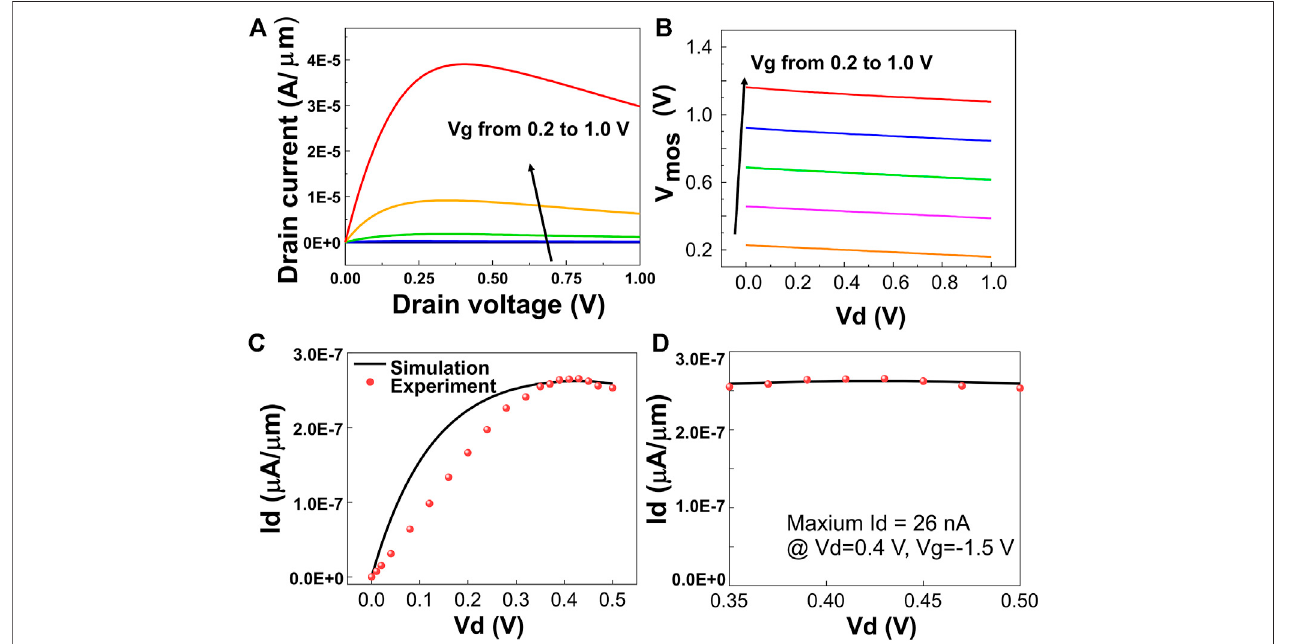
FIGURE 4 | NDR effect in device modeling. (A) NDR effects in the simulated output characteristics of NC2D FETs under different gate voltages. (B) Simulated underlying MOSFET gate voltage V MOS (internal voltage); the same color means under the same condition with (A) . (C) Simulated NDR effect against the experimental measurement of CIPS incorporated NC2D FETs. (D) Simulation results against experiments in the NDR region.